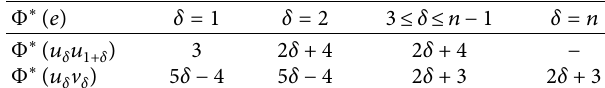
Table 14: Edge labeling of Φ ∗ ( e ) .